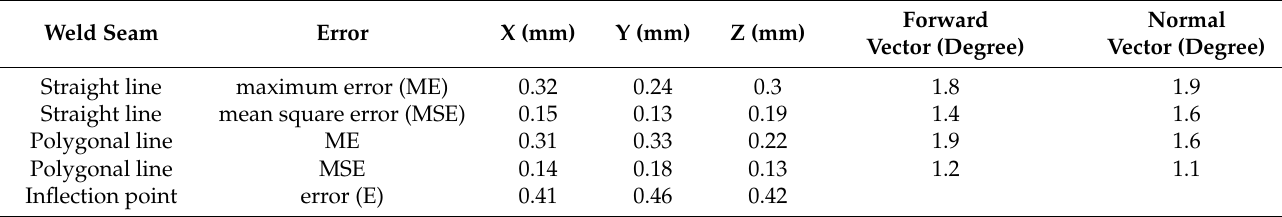
Figure 14. Real-time tracking results of 3D zigzag-line welding seams; ( a – c ) The real-time tracking results of 3D zigzag-line welding seams with fold angles of 130°, 150°, 170°, 180°, 190°, 210° and 230°. 4.3. Error Analysis We obtained the extraction error by comparing the data for the 3D zigzag-line weld- ing seams read by the robot through accurate teaching with the points corresponding to the calculated values. With the maximum error (ME) and the mean square error (MSE) on